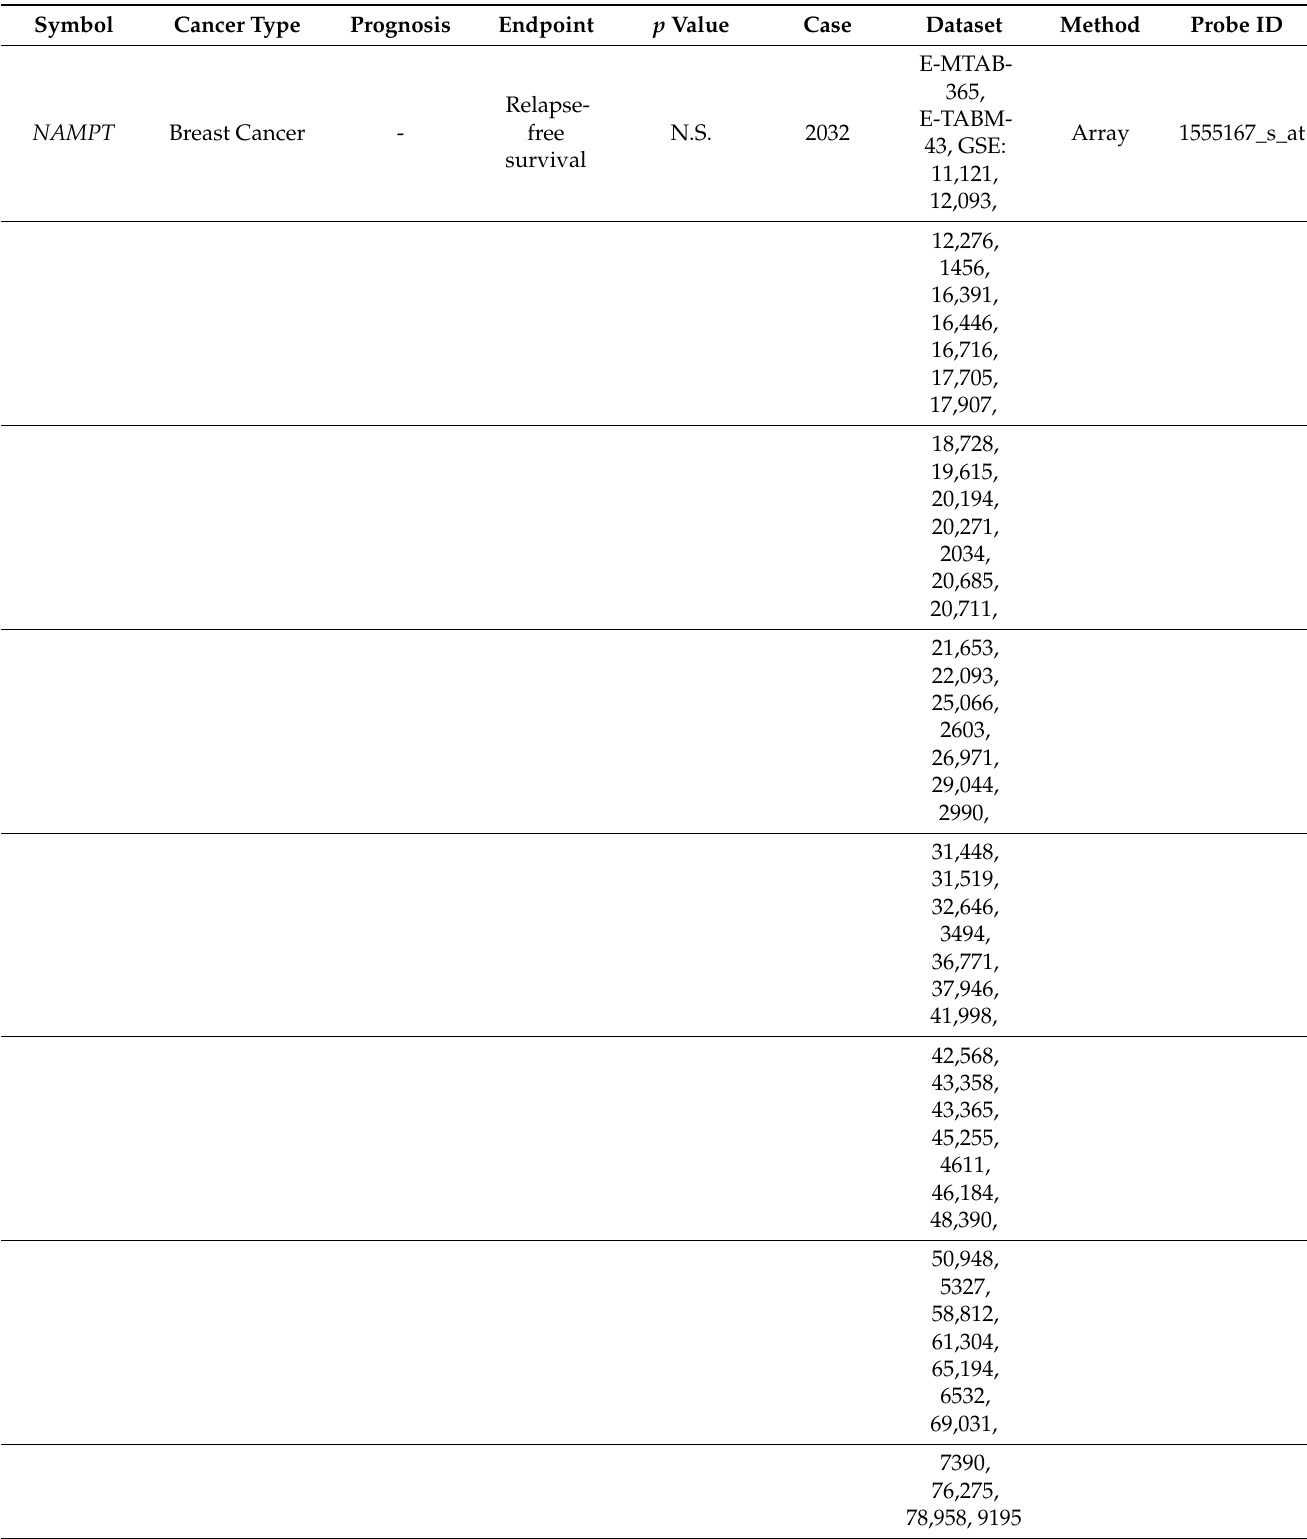
Table 3. Correlation of NAMPT with cancer patient